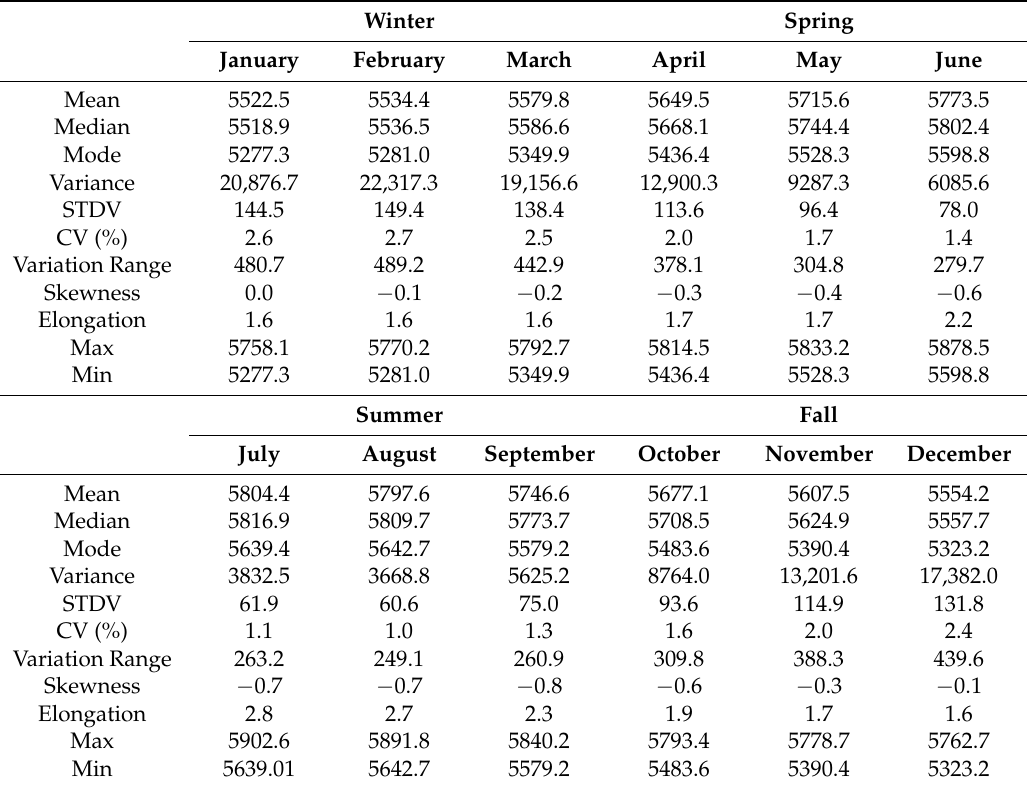
Table 1. Spatial features of Atmospheric Thickness (AT) for each month in Iran (m). Winter